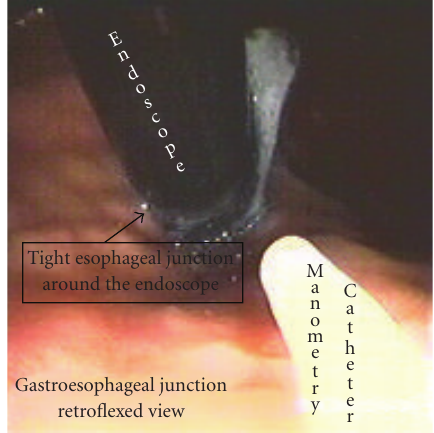
Figure 2: This picture shows a retroflexed view of the gastroe- sophageal junction in a normal volunteer. The white catheter is the manometry catheter and the black tube is the endoscope. Note that the gastroesophageal junction is tight around the endoscope prior to air insu ffl ation into the